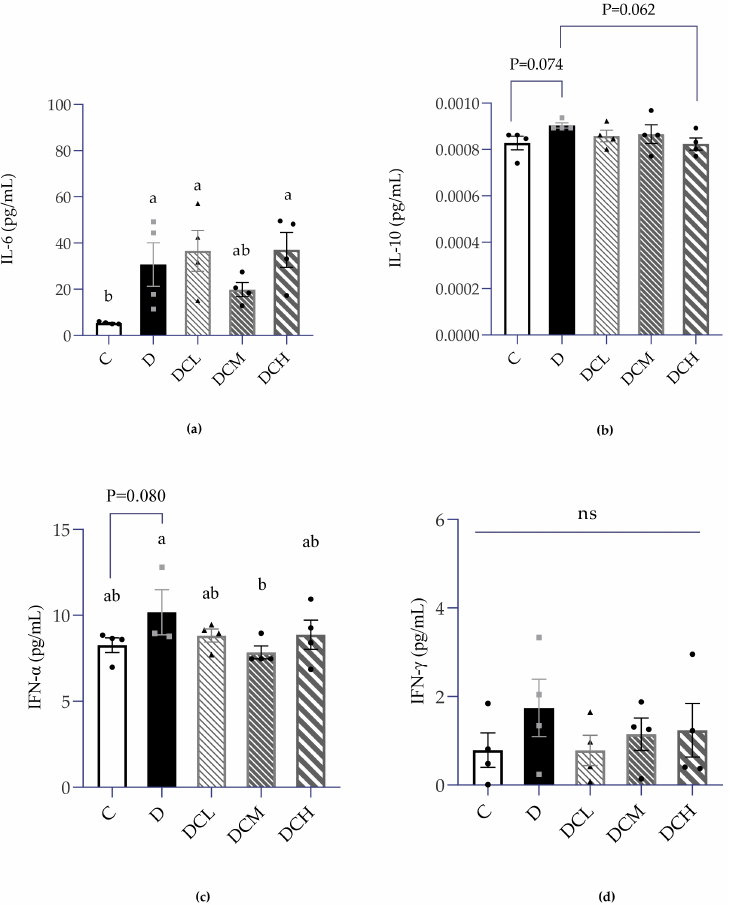
Figure 7. Expression of inflammatory factors in serum. ( a ) IL-6, n = 8. ( b ) IL-10, n = 8. ( c ) IFN- α , n = 6–8. ( d ) IFN- γ , n = 8. In this figure, a dot represents two mice. Results were expressed as mean ± SEM. (cid:78) • (cid:4) : The number of symbols was consistent with the number of samples, and the relative position represented the degree of data dispersion. Parameters marked by the same alphabet are not significantly different. Significance is expressed as p <